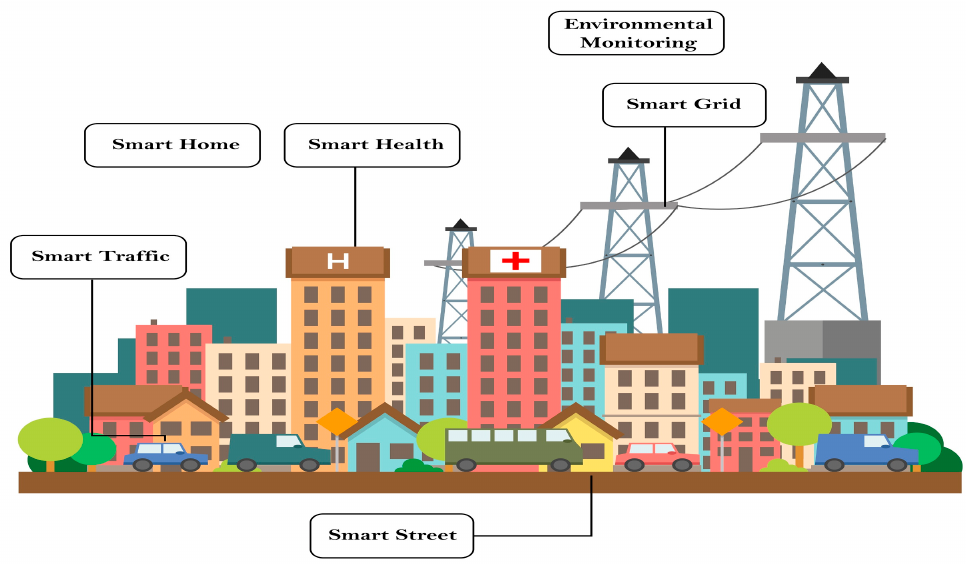
Figure 1. Smart city architecture based on IoT.